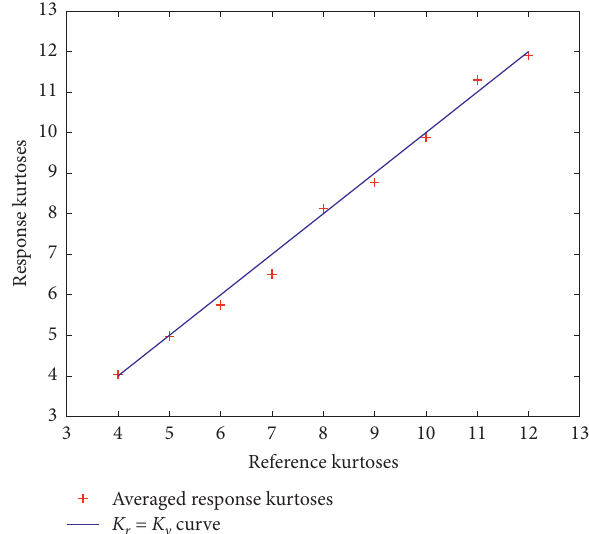
Figure 26: Numerical relation between the reference kurtoses and the response kurtoses: K r � K y curve (solid line). Averaged kurtoses of the response acquired from the experiment (plus